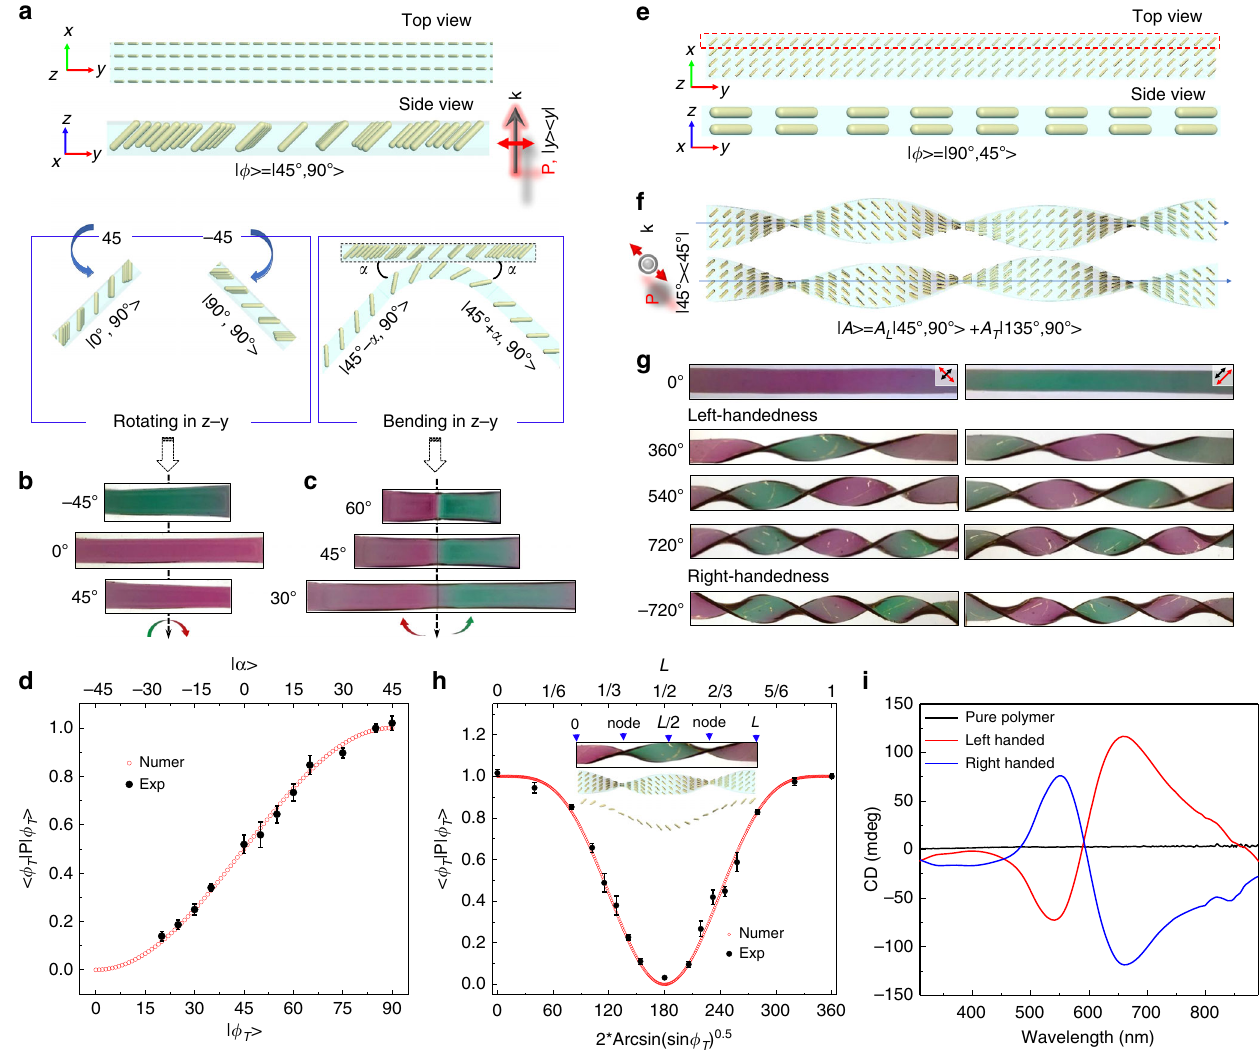
Fig. 4 Motion-active plasmonic fi lms. a Schematics of the speci fi c arrangement of cAuNRs in the plasmonic fi lm. b Top views of the plasmonic fi lms under different rotation angles. c Top views of the plasmonic fi lms under different bending angles. d The transverse excitation of cAuNRs under different transverse phase angles ( ɸ T ). e Schematics showing the in-plane 45° arrangement of cAuNRs inside the plasmonic fi lm at the top (top) and side view (bottom). f Schematics of left-handed twist (top) and right-handed twist states (bottom). The twisting angle is set at 540°. g Digital images of the plasmonic fi lm at initial (top panel), left-handed (middle panel), and right-handed twisting states (bottom panel). The polarization direction and orientation of cAuNRs are illustrated by red and black arrows, correspondingly. h Dependence of transverse excitation on localized rotation angle and y -coordinates by analyzing the superposition of intensity of transverse and longitudinal resonances to the overall lineshape. Insets: a picture of the twisted plasmonic fi lm and the helical con fi guration of cAuNRs. i CD spectra of pure polymer and plasmonic fi lms under twisted con fi guration. Error bars in d and h represent the standard deviations from three experimental